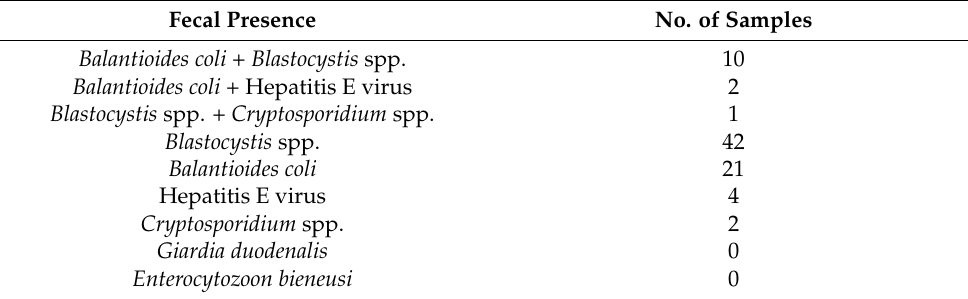
Table 2. Summary of pathogen detection in stools. Fecal Presence No. of Samples Balantioides coli + Blastocystis